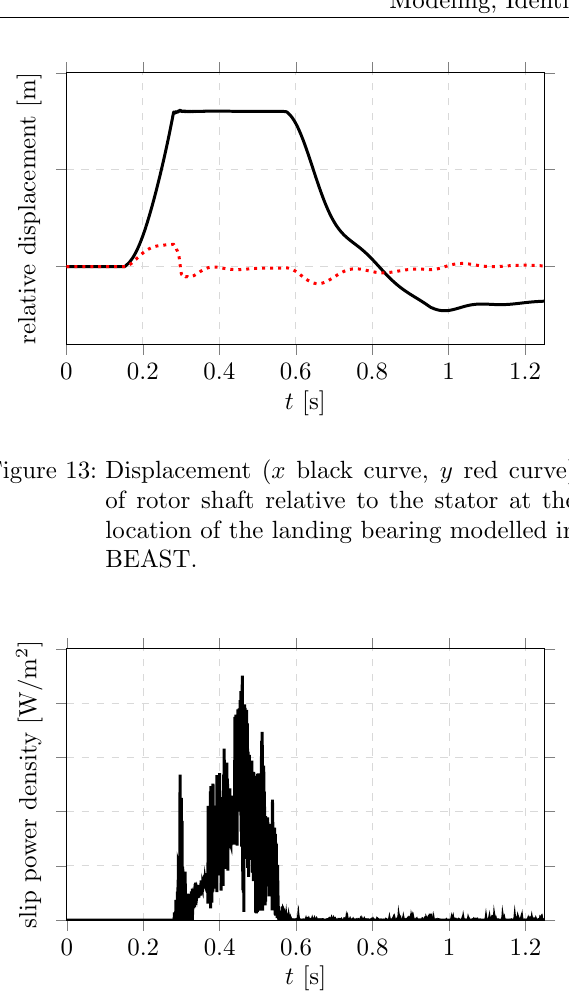
Figure 14: Maximum slip power loss density for all bal- l/raceway contacts in the landing